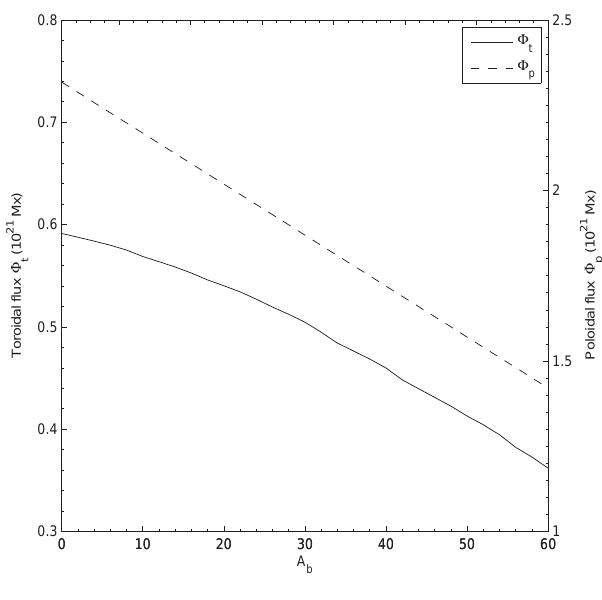
Fig. 12. Fluxes inside different boundaries of the vector potential A b , from the inside of the flux rope (right) to the outside